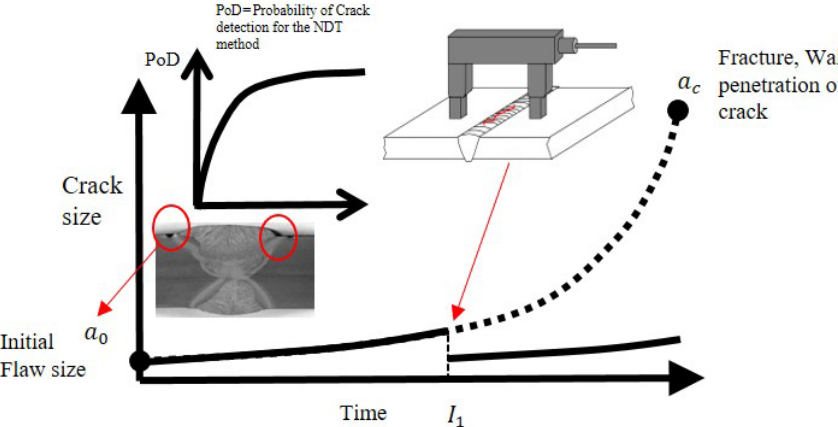
Figure 2. Crack growth curve diagram.